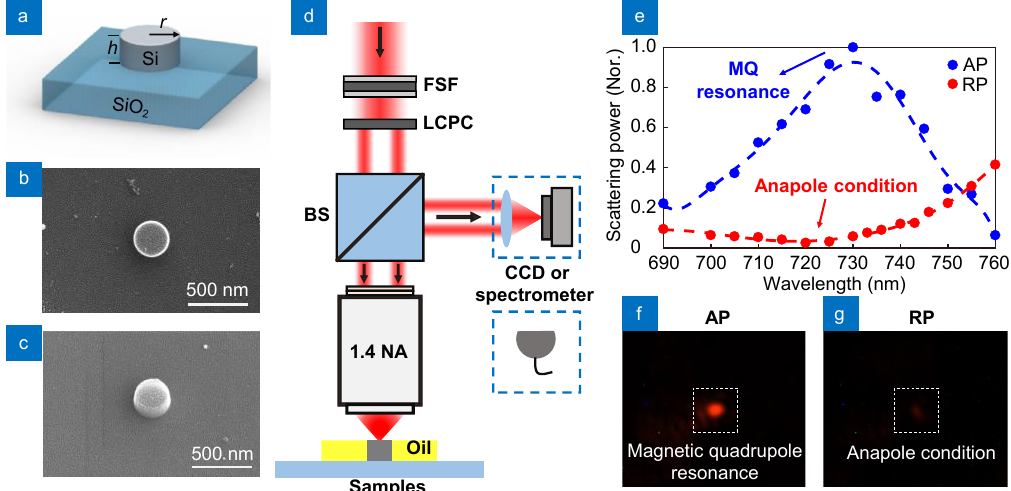
Fig. 5 | ( a ) A Si nanodisk fabricated on a glass substrate, where h = 160 nm and r = 150 nm indicate its height and radius. SEM images of the Si nanodisk from top ( b ) and side ( c ) views. ( d ) Optical setup for the back scattering spectroscopy of CVBs. FSF, Fourier spatial filter; LCPC, liquid crystal polarization converter; BS, beam splitter; CCD, charge coupled device; NA, numerical aperture. ( e ) Experimental measured back scatter- ing spectra of a Si nanodisk excited by AP (blue) and RP (red) beams under the same excitation power, respectively. The dashed lines are guide to the eye. CCD images under the MQ resonance condition excited by a focused AP ( f ) and the anapole condition excited by a focused RP ( g ). The excitation wavelengths for (f) and (g) are both 735